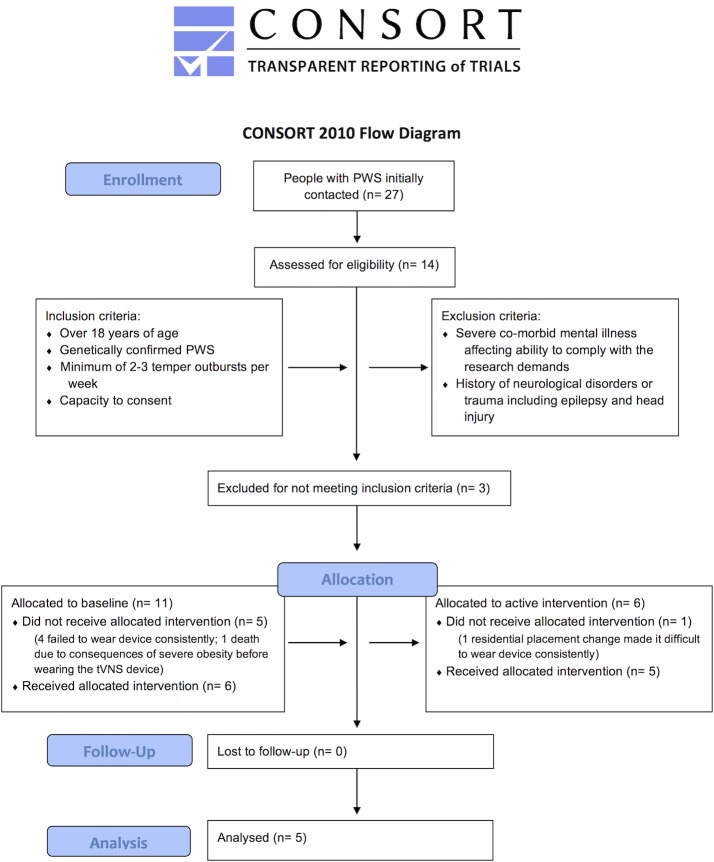
Consolidated Standards of Reporting Trials (CONSORT) flow chart.CONSORT flow chart illustrating all steps in the study from enrollment to allocation and follow up. Inclusion and exclusion criteria are also specified.